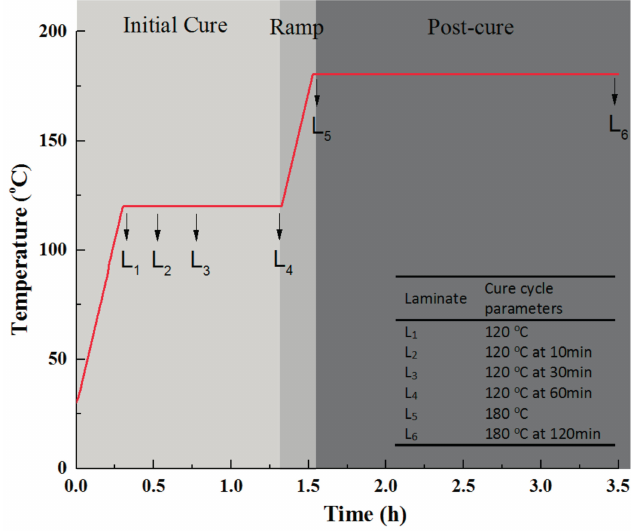
Figure 12. Laminates used to investigate resin impregnation evolution during rapidly cured